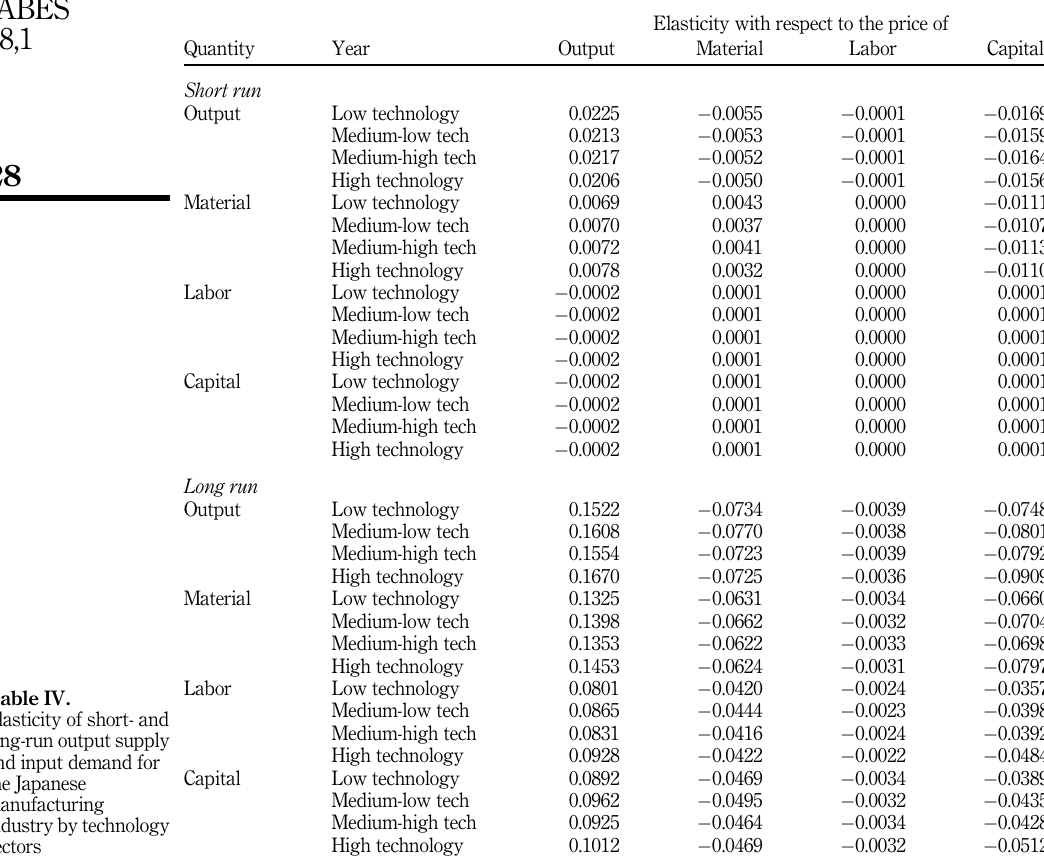
Table IV. Elasticity of short- and long-run output supply and input demand for the Japanese manufacturing industry by technology